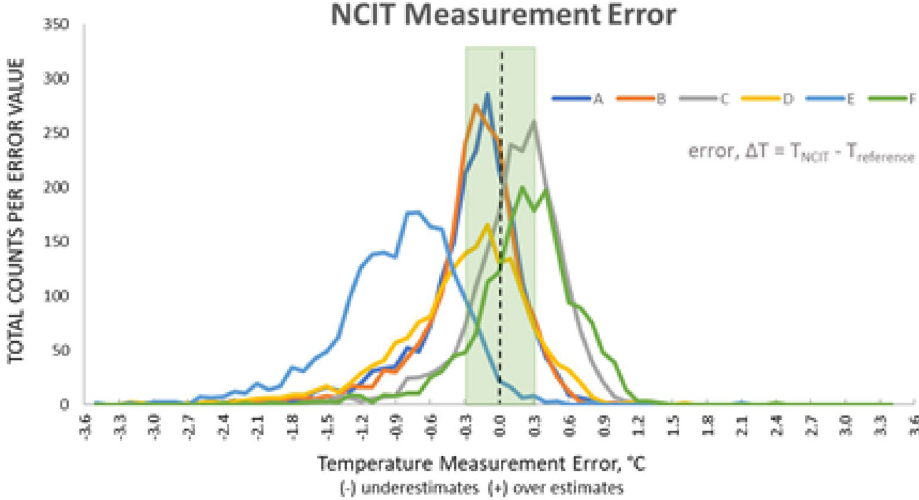
Figure 2. Total counts per error value, per NCIT model for Trial #1 and #2. Green area indicates ± 0.3 °C laboratory accuracy zone; dashed black line indicates the zero error